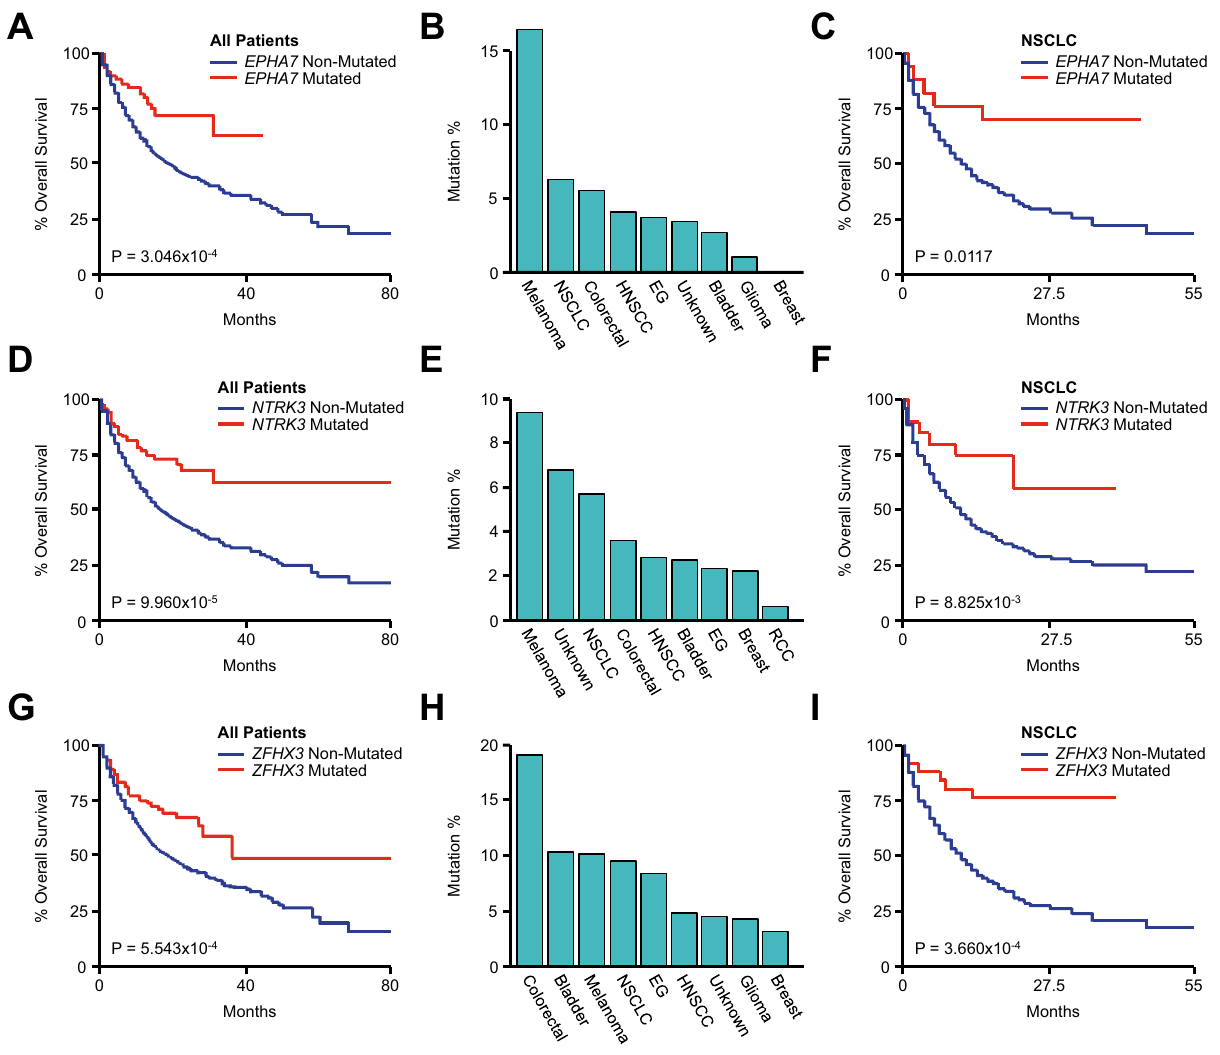
Figure 7. EPHA7, NTRK3, and ZFHX3 mutations are associated with improved survival in lung cancer patients receiving immune checkpoint inhibitors. ( A ) Kaplan Meier plot showing overall survival for the pan-cancer cohort (N = 1661) arranged by EPHA7 mutation status (86 EPHA7 -mutated and 1316 EPHA7 - non-mutated patients. An additional 259 EPHA7 -unprofiled patients were excluded from analysis). ( B ) The percent of EPHA7 -mutated patients arranged by tumor type. ( C ) Overall survival for the non-small cell lung cancer (NSCLC) cohort arranged by EPHA7 mutation status (N = 350, 18 EPHA7 -mutated and 265 EPHA7 - non-mutated patients. An additional 67 EPHA7 -unprofiled patients were excluded from analysis). ( D ) Kaplan Meier plot showing overall survival for the combined pan-cancer cohort arranged by NTRK3 mutation status (76 NTRK3 -mutated and 1585 NTRK3 -non-mutated patients). ( E ) The percent of NTRK3 -mutated patients arranged by tumor type. ( F ) Kaplan Meier plot showing overall survival for the NSCLC cohort arranged by NTRK3 mutation status (20 NTRK3 -mutated and 330 NTRK3 -non-mutated patients). ( G ) Kaplan Meier plot showing overall survival for the pan-cancer cohort arranged by ZFHX3 mutation status (118 ZFHX3 -mutated and 1284 ZFHX3 -non-mutated patients. An additional 259 ZFHX3 -unprofiled patients were excluded from analysis). ( H ) The percent of ZFHX3 -mutated patients arranged by tumor type. (I) Overall survival for